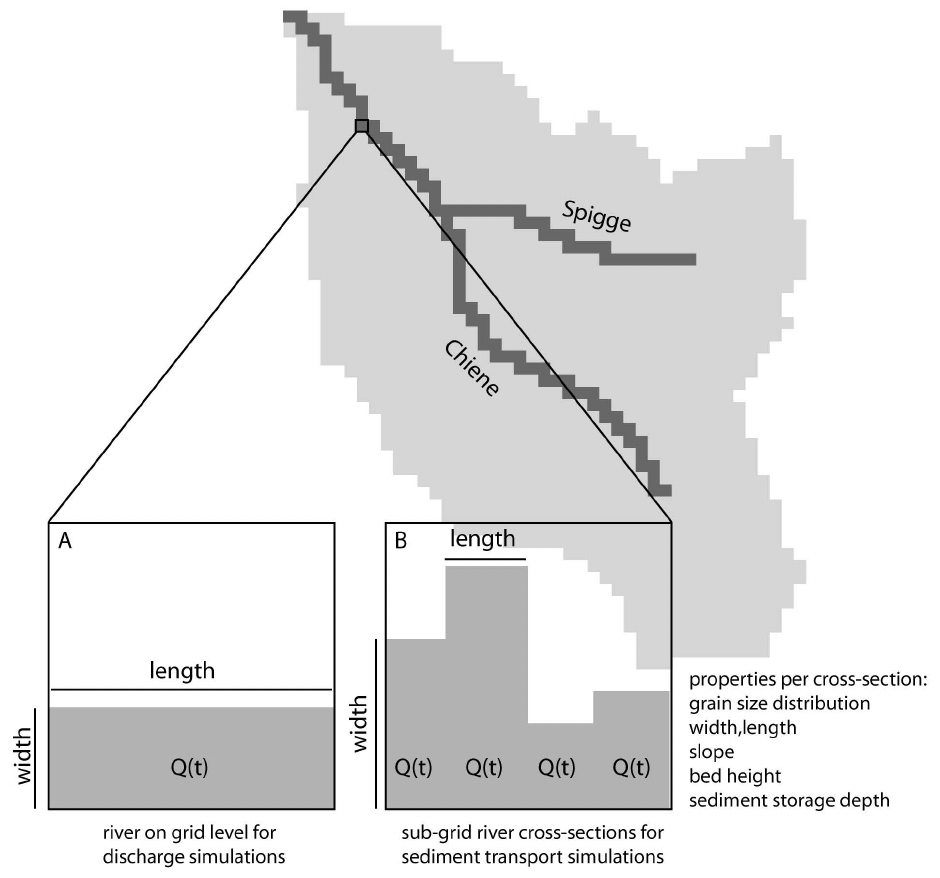
Fig. 3. Sub-grid concept of river cross-sections. A : River representation for hydraulic simulations on the grid level; B : Sub-grid cross-sections for sediment transport